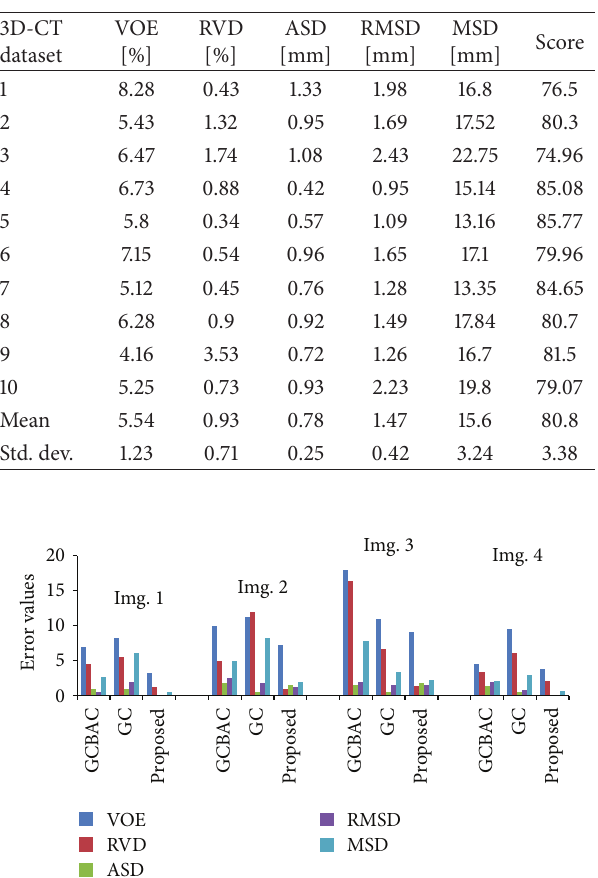
Table 2: Evaluation on the MICCAI dataset.